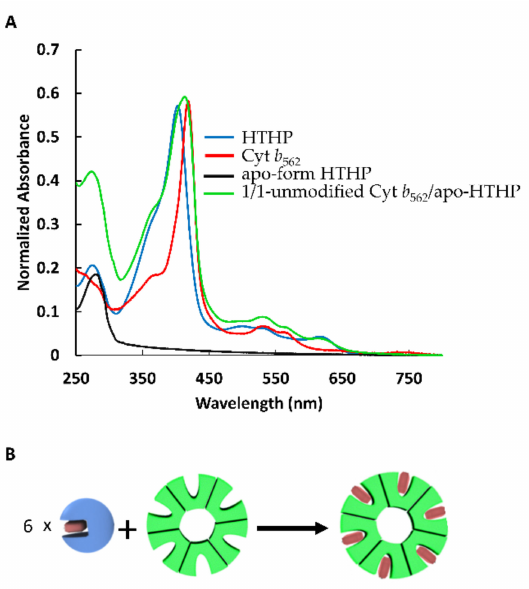
Figure 3. ( A ) The UV-Vis spectra measured at pH 7.0 in 0.1 M potassium phosphate buffer of HTHP (light blue), Cyt b 562 (red), apoHTHP (black), and equimolar mixture of Cyt b 562 and apoHTHP in the same amount as that of the heme binding site (green). ( B ) Schematic representation for the mixing of equivalent unmodified Cyt b 562 and